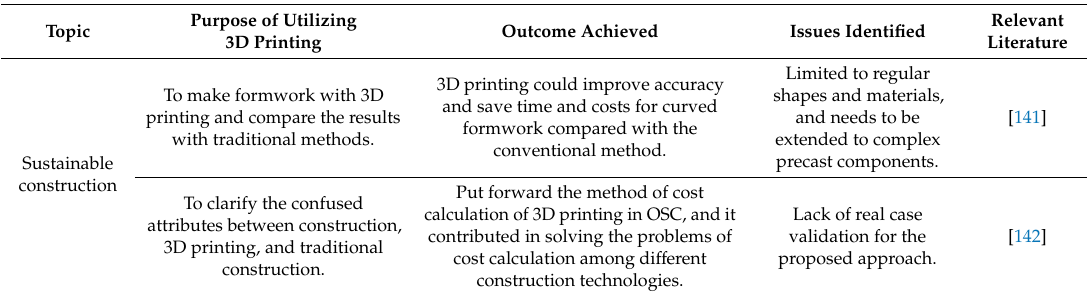
Table 15. Research topics, purpose of three-dimensional (3D) printing adoption, and outcomes achieved in previous studies.